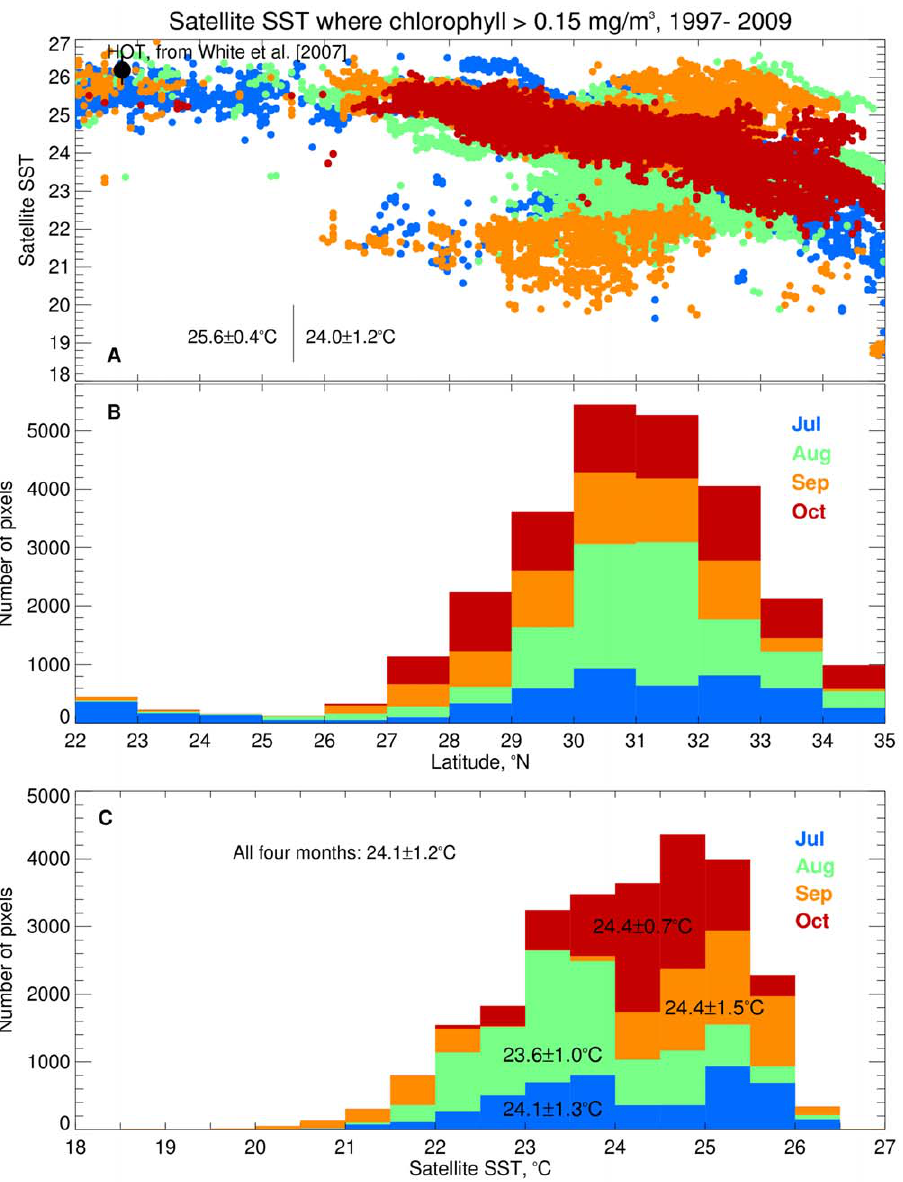
Figure 9. Temperature range for summer blooms detected by ocean color. A. Satellite sea surface temperature (SST) versus latitude presented as stacked bar graphs for areas with satellite chlorophyll . 0.15 mg m 2 3 between 22–35 u N and 160–130 u W during July-Oct. for the years 1997–2009. B. Histogram of the prevalence of blooms against latitude. C. Histogram of the prevalence of the SST of the blooms. The data are color- coded by month: July data are blue, August is green, September is orange and October is red. In (A) the average and standard deviation of SST for blooms at Sta. ALOHA that were given in White et. al {, 2007 # 22784} are shown by the black circle and error bars. Because of the large number of points (N=26,302) in (A) not all of them are visible and the plotting order (July–Oct) makes points in Oct. appear more prevalent. The average and standard deviation of the SST south and north of 25.5 u N is shown in (A).